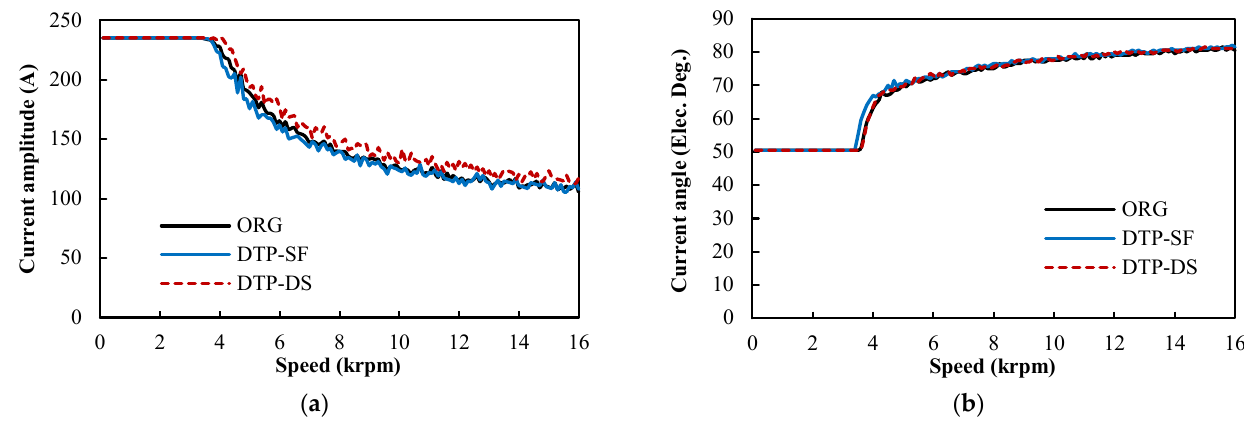
( c ) Figure 29. d- and q-axis currents of different winding configurations over entire speed range: ( a ) ORG; ( b ) DTP-SF; ( c ) DTP-DS. According to the d- and q-axis currents shown in Figure 29, the amplitudes and cur- rent angles of phase currents in the three windings over the entire speed range are shown in Figure 30a,b. It should be mentioned that the phase current amplitudes in DTP-SF and